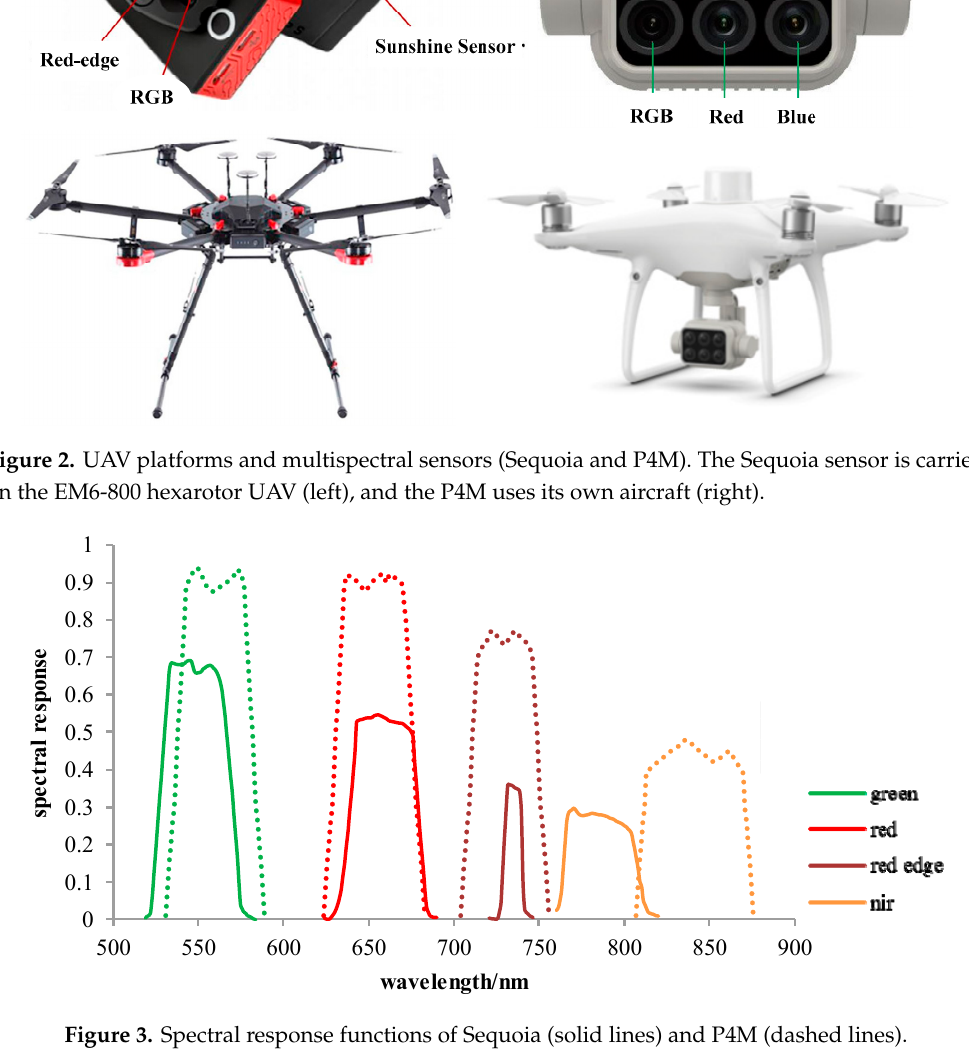
Figure 3. Spectral response functions of Sequoia (solid lines) and P4M (dashed lines).